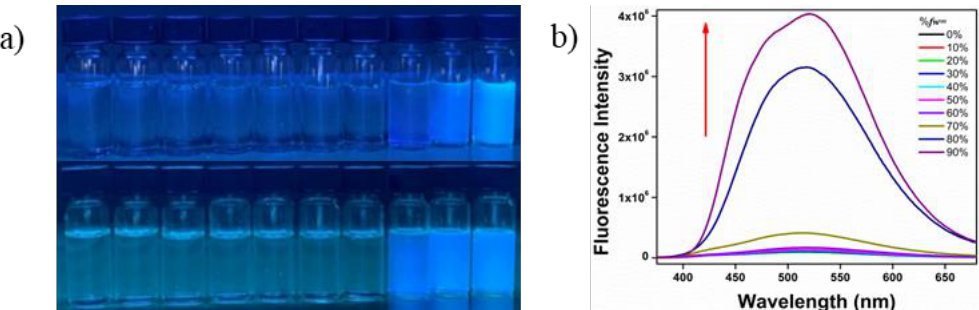
Figure 4. ( a ) Solutions of DTITPE (1 × 10 −5 M) in THF containing, from left to right, increasing amounts of water ( f w , 0–90 vol%) under UV irradiation (top: 185 nm; bottom 365 nm). ( b ) Fluorescence emission spectra of DTITPE (1 × 10 −5 M) in THF containing increasing amounts of water ( f w , vol%).